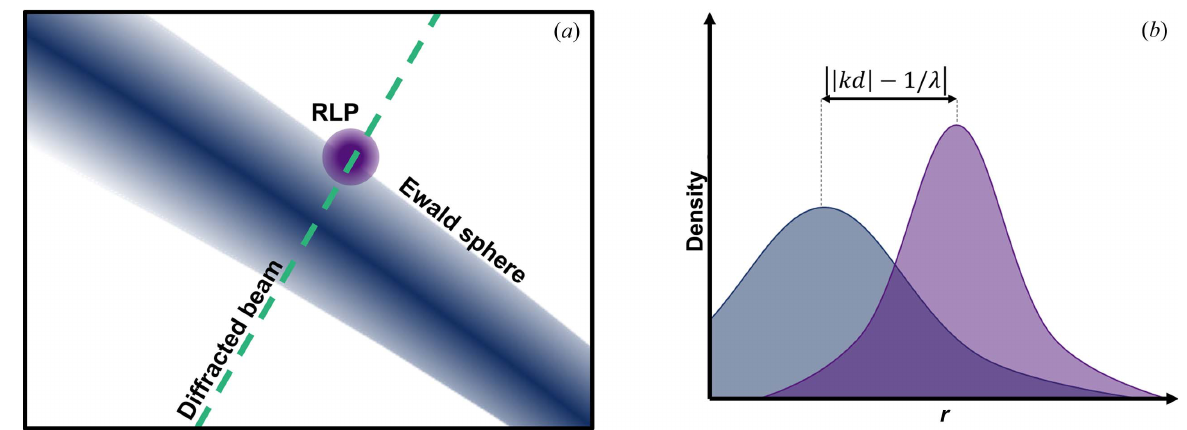
Figure 9 Schematic of the combined spectral width and partiality correction. ( a ) A cut-out of the Ewald sphere intersection with a single RLP is shown. ( b ) S par is calculated from the integration of the product of the Ewald sphere density and the RLP density function along the diffracted beam path, r